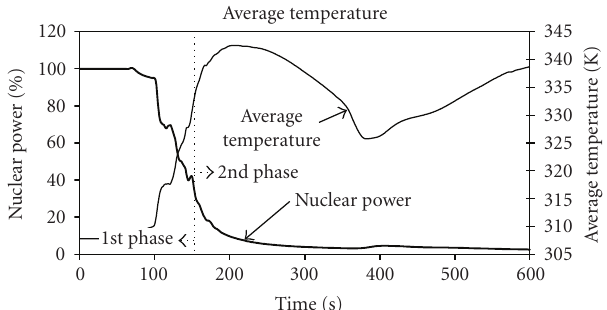
Figure 9: Average temperature and nuclear power (AMSAC tran- sient).